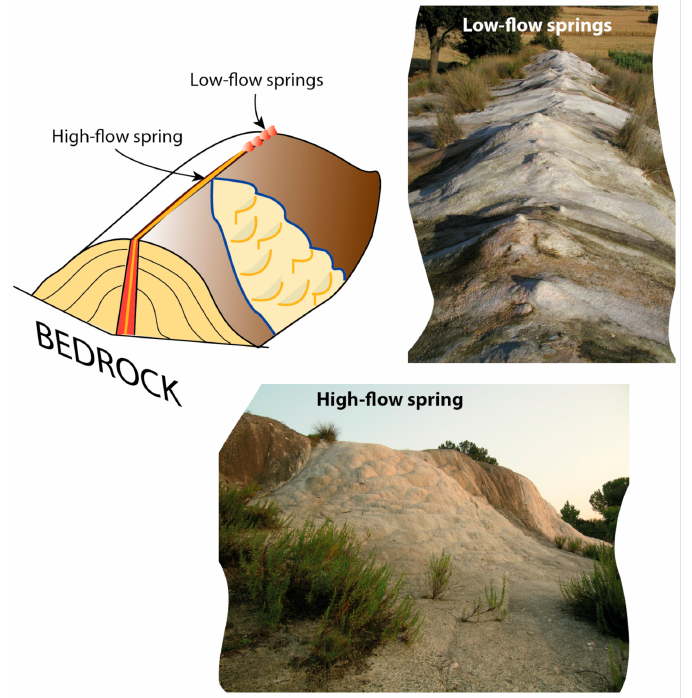
Figure 7. Diagram and photographs illustrating the formation of cones aligned along the fissure at the top of the ridge and the lateral slope depositional setting in relation to the flow spring. See the text for more information.